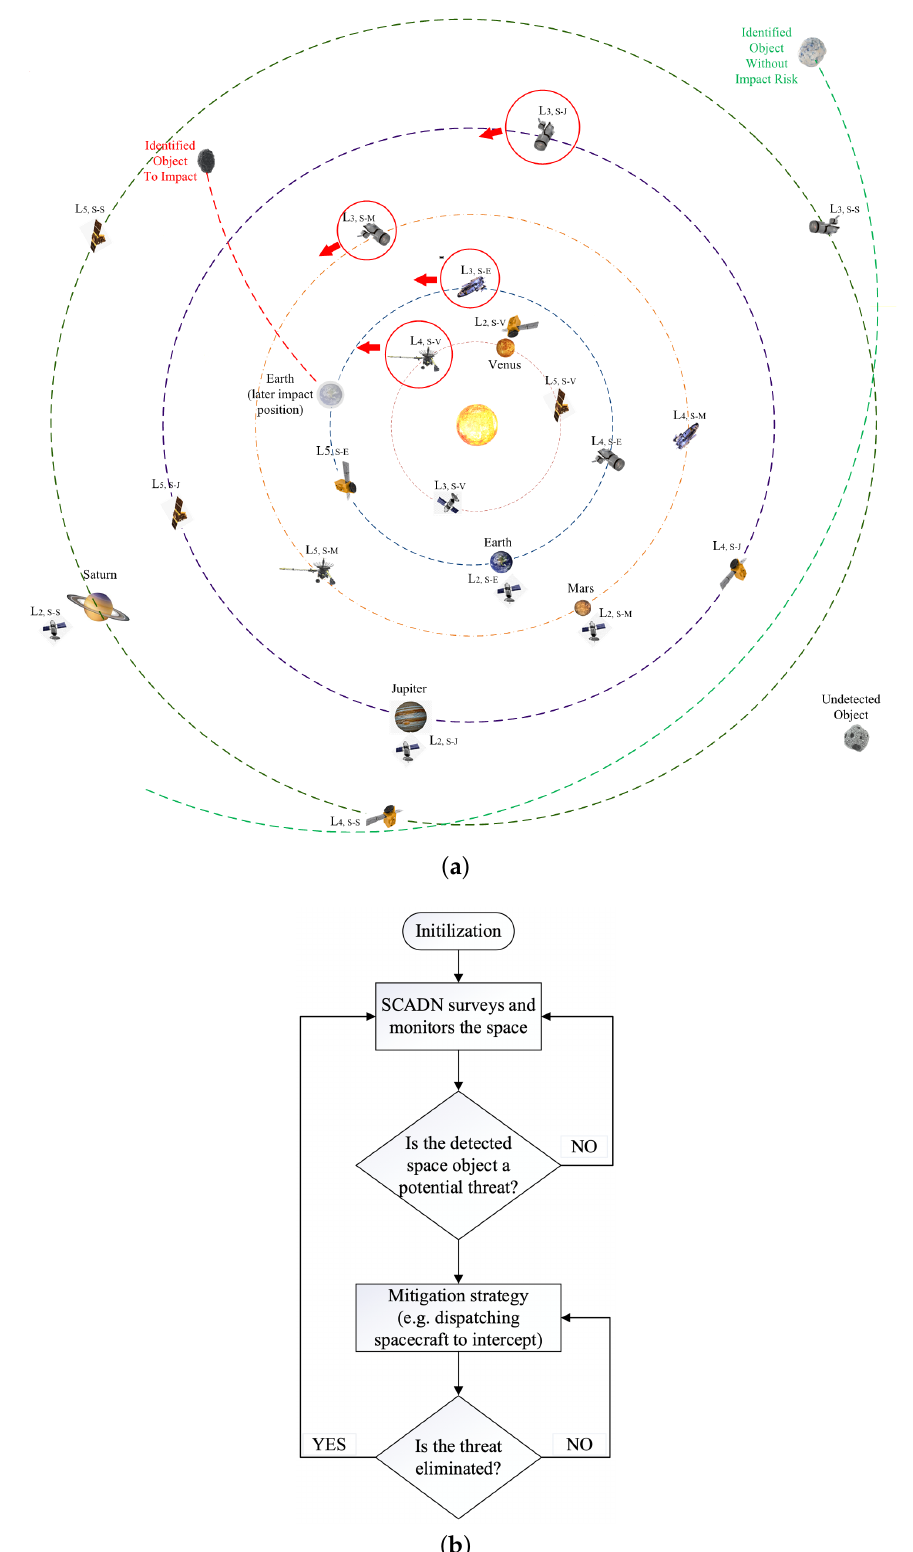
Figure 19. ( a ) Illustration of the SCADN framework which monitors the space and detects and intercepts the hazardous space objects (dimension of celestial bodies, space objects, and orbits are not scaled); and ( b ) a brief flowchart of the SCADN